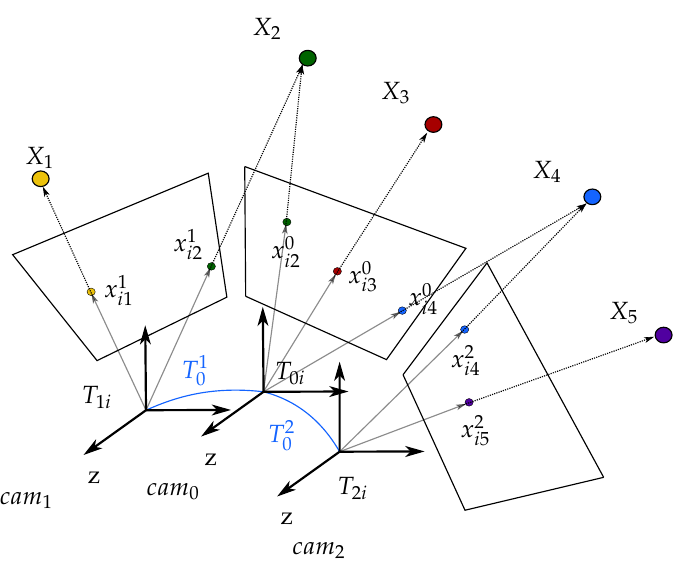
Figure 1. A multi-camera simultaneous localization and mapping (SLAM) system. The extrinsic parameters between cameras are indicated in blue. Observing the same points with cameras looking from different viewpoints provides a great advantage for